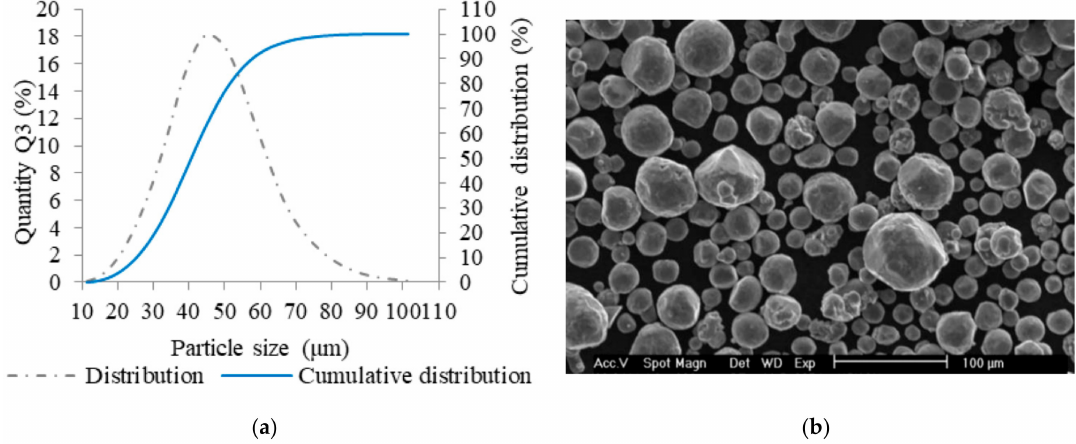
Figure 2. Selective laser melting (SLM) powder characteristics; ( a ) chart of particle size distribution; ( b ) shape of powder particles (scanning electron microscopy